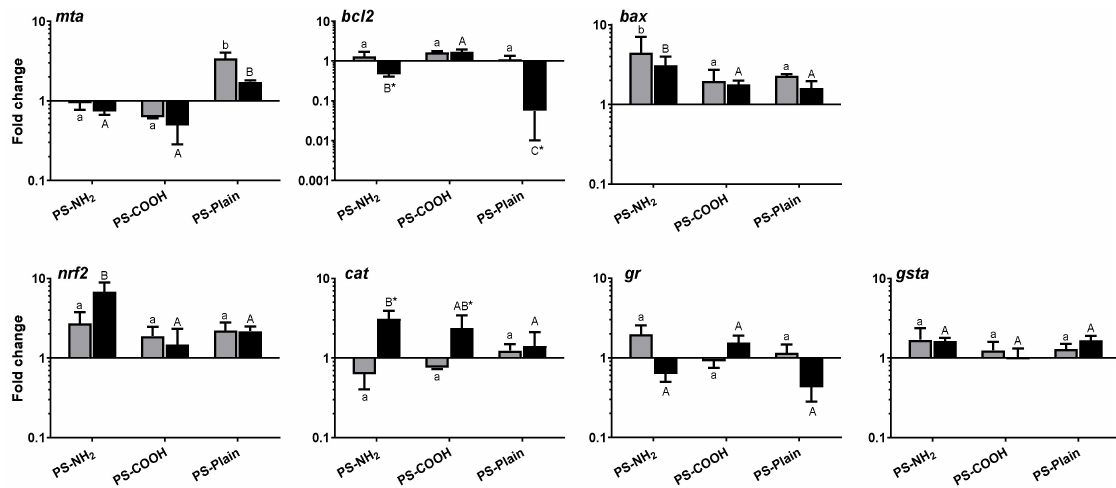
Figure 3. Transcriptional profile of SaB-1 cells exposed to 1 (grey bars) or 12 (black bars) µ g mL − 1 of functionalized polystyrene nanoplastics (PS-NH2, PS-COOH and PS-Plain) for 24 h. Data are presented as mean fold change of the relative gene expression in NP-exposed cells compared to unexposed cells ± SEM ( n = 3). Different lowercase and uppercase letters denote significant differences between functionalized NPs at 1 µ g mL − 1 or 12 µ g mL − 1 , respectively whilst significant